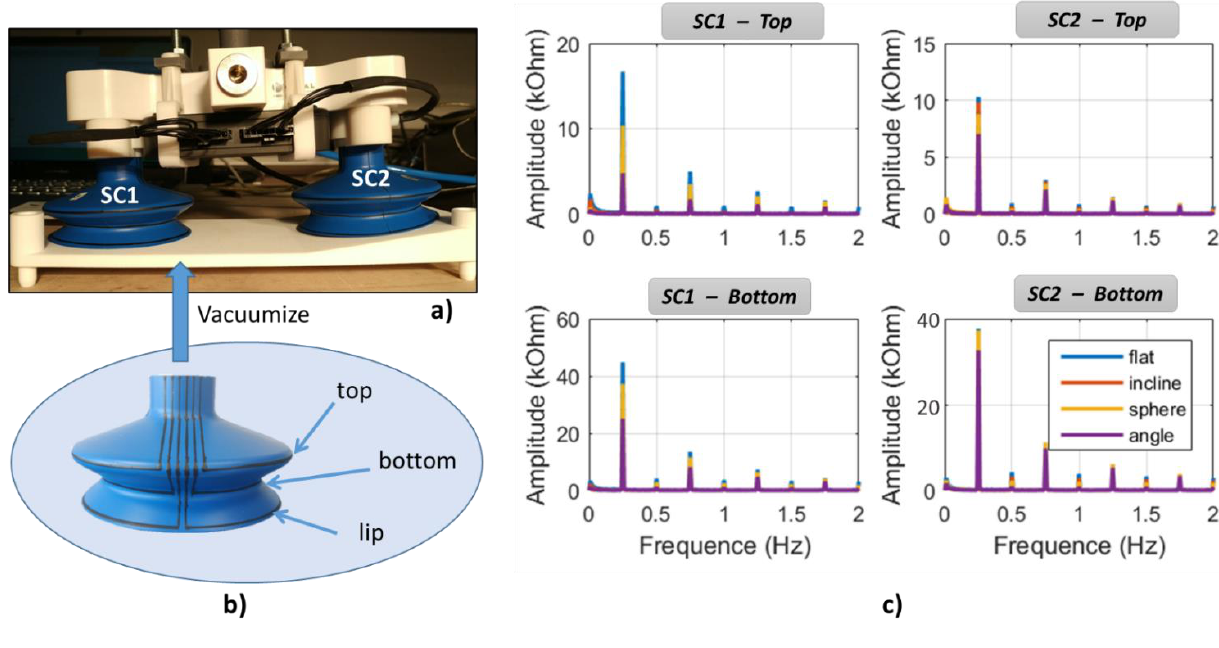
Figure 13. Resistance variation measured on different configurations: ( a ) setup of 2 suction cups (SC1 et SC2), ( b ) three sensors coated on the samples, ( c ) resistance variation of the top and bottom bellows measured on different surfaces for SC1 et SC2.